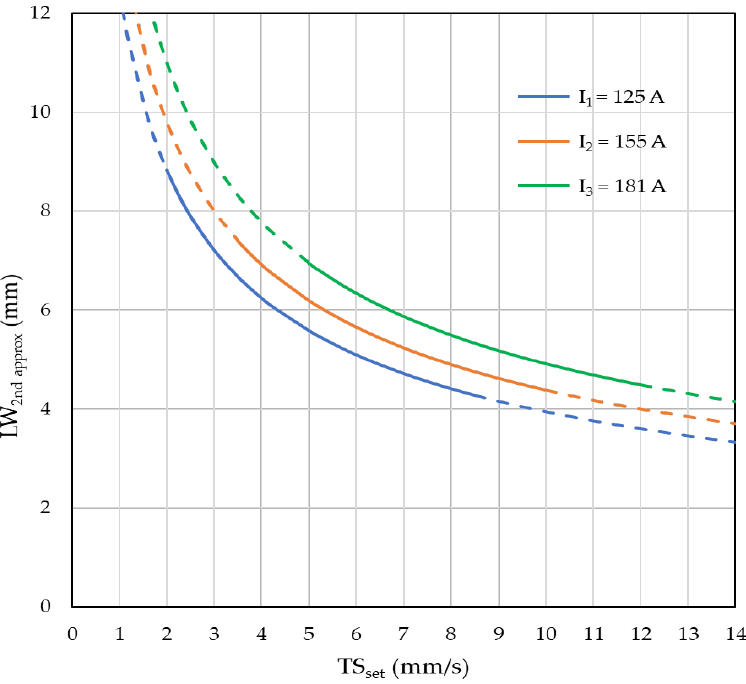
Figure 11. Second approximation operational map with actual current range and representing the boundaries for workable limits of current and travel speed (LW is still estimated by Equation (5)).